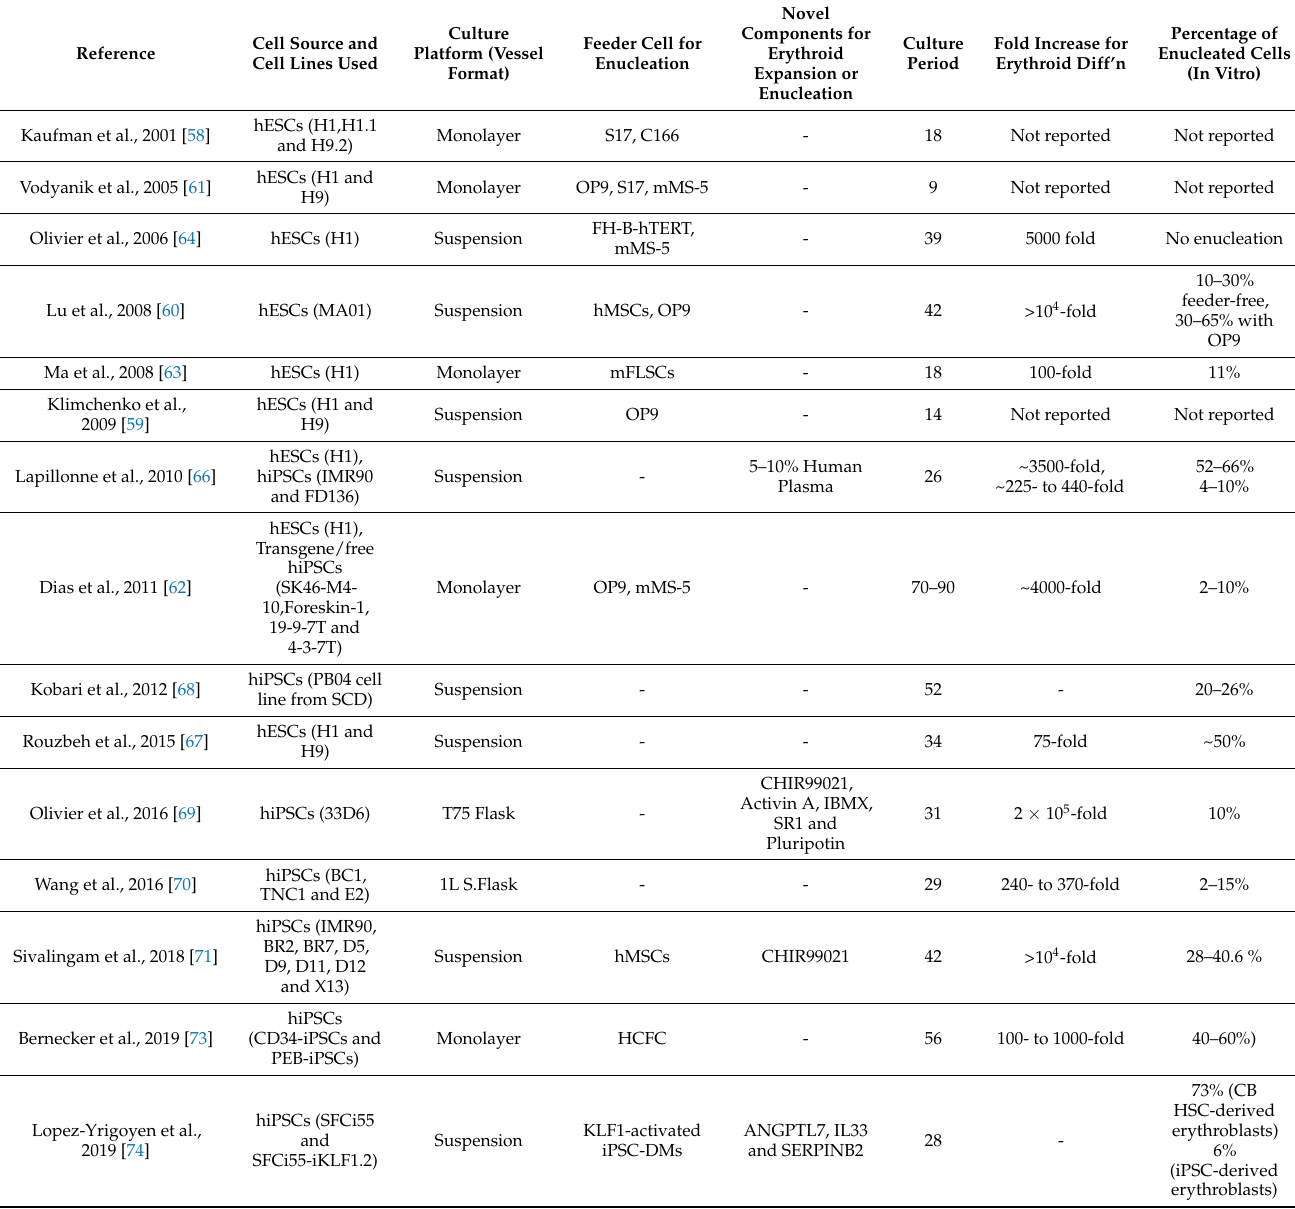
Table 1. In vitro cRBC generation from hESCs and